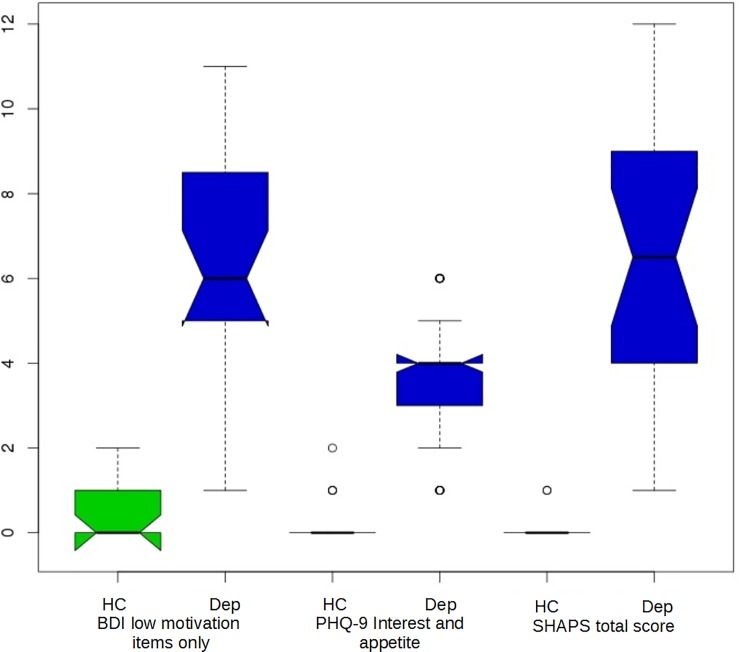
All clinical measures of motivation clearly separate the healthy control (HC, odd plots) from the depression (Dep, even plots) sample.Shown are summed items ‘loss of interest’, ‘change in appetite’ and ‘loss of interest in sex’ from the Beck Depression Inventory BDI), ‘interest’ and ‘appetite’ items from the Patient Health Questionnaire– 9 (PHQ-9) and the total score of the Snaith-Hamilton Pleasure Scale (SHAPS). For each pairwise comparison, Wilcoxon p < 1e-06.